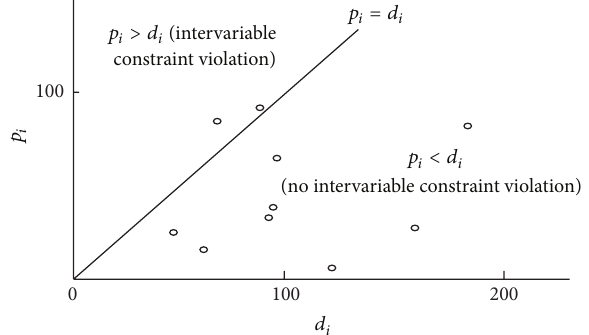
Figure 1: Two-dimensional spaces illustrating invalid subdomains where 𝐷 𝐿 < 0 .